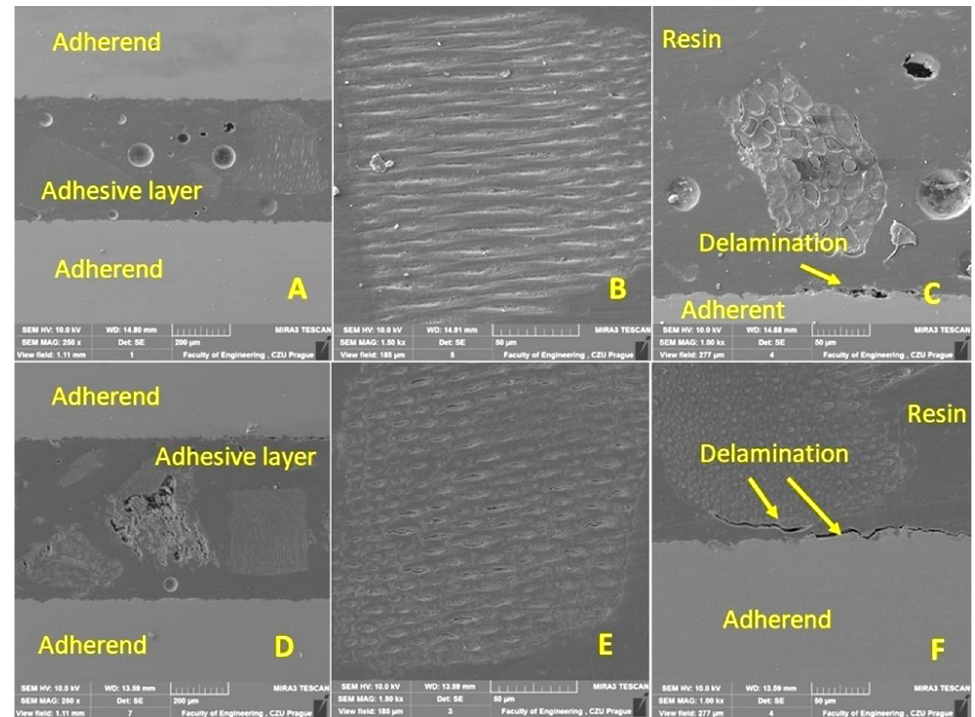
Figure 12. SEM analysis of a cross-section of a hybrid adhesive layer with S-filler (SE detector Oxford): ( A ): Cross-section of a hybrid adhesive layer with S-filler (MAG 250×), ( B ): Interaction between S-filler and resin (MAG 1500×), ( C ): Interaction between hybrid adhesive layer and adherend (MAG 1000×), ( D ): Cross section of a hybrid adhesive bond with S_NaOH (MAG 250×), ( E ): Interaction between S_NaOH (MAG 1500×), ( F ): Interaction between hybrid adhesive layer and adherend (MAG 1000×).